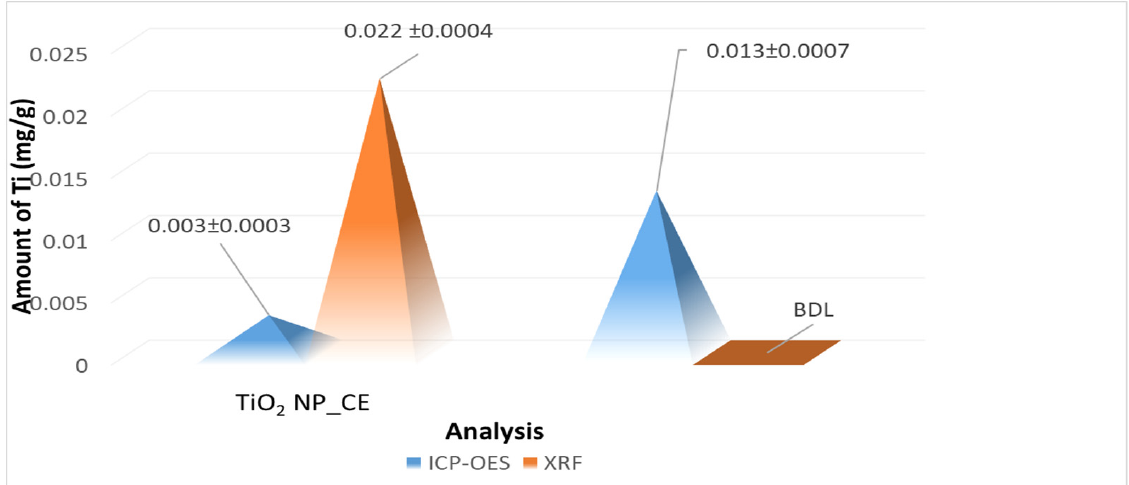
Figure 8. XRF and ICP–OES measurements of TiO 2 NPs (mg/g) in P. granatum seeds exposed to TiO 2 NPs_PPE and TiO 2 NPs_CE. The amount of Ti element is expressed as mean values obtained from sample replicates used for investigation, i.e., mean ± SE.